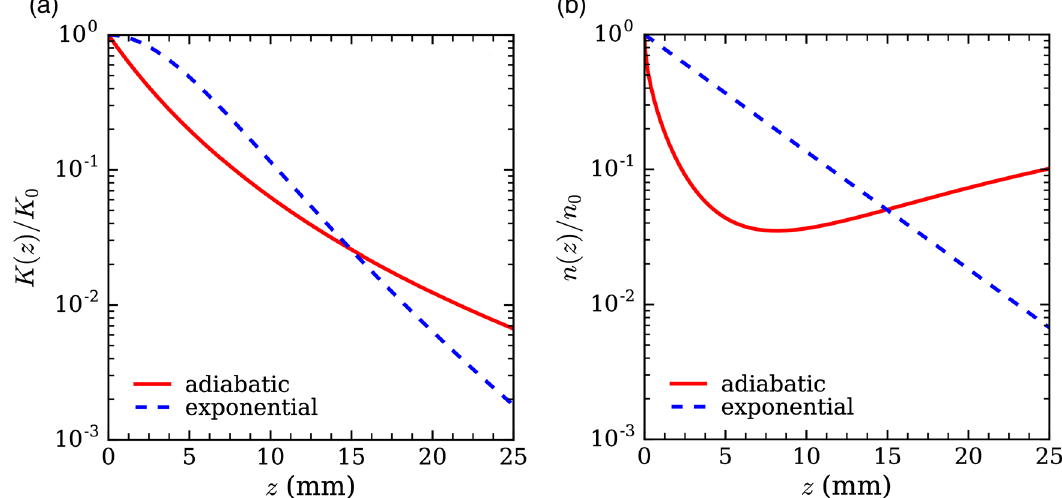
FIG. 5. Focusing gradient (a) and corresponding plasma density profiles (b) for adiabatic ( g ¼ 100 m − 1 ) and exponential ¼ 7 mm) down ramps. ( L exp